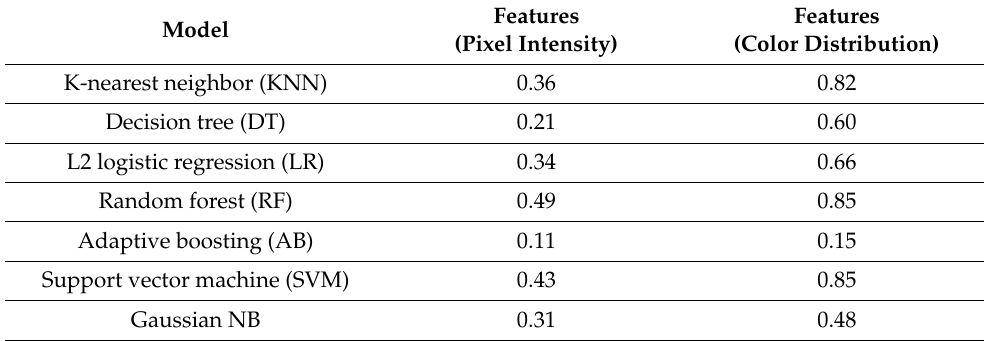
Table 6. Performance of machine learning algorithms.